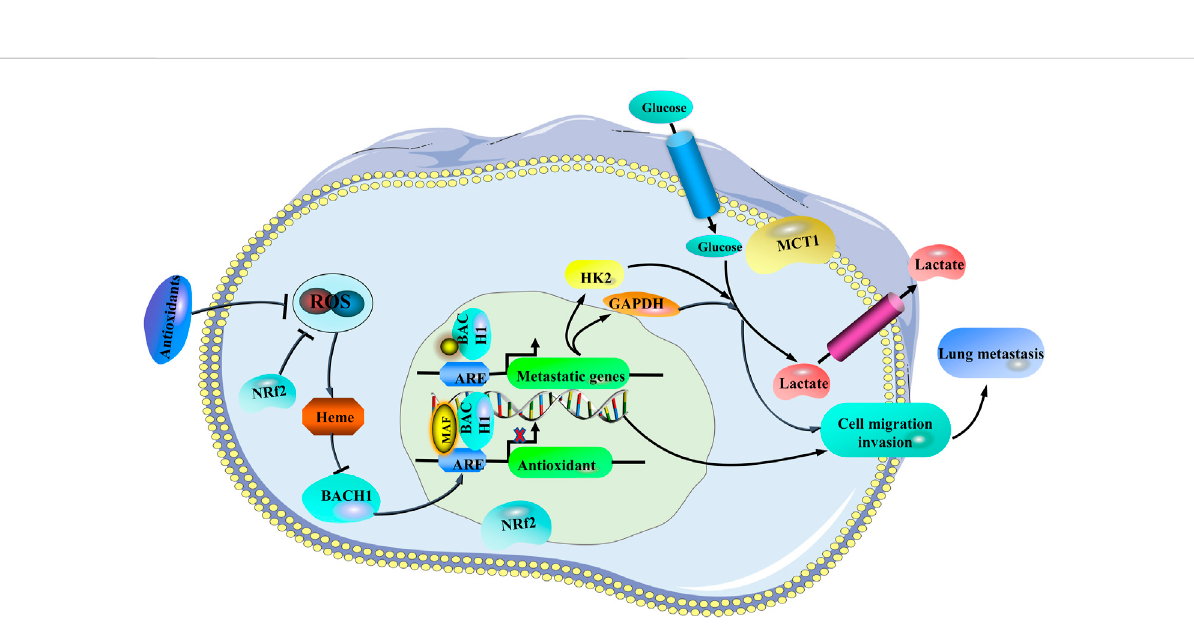
FIGURE 5 Antioxidative